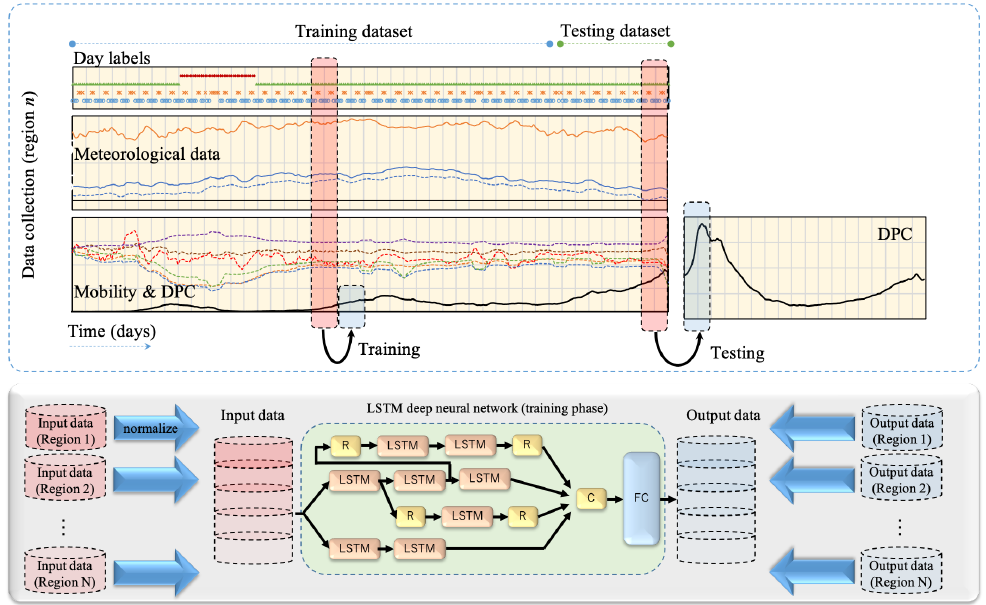
Figure 4. LSTM deep neural network is trained using day labels (working/vacation and normal/SoE), meteorological data (max/min temperature and average humidity), community mobility, and DPC. Network output is the estimated DPC. R, C, and FC indicate sequence reverse, concatenation, and fully connected layers. Training data acquired for different districts were normalized and merged for an efficient training